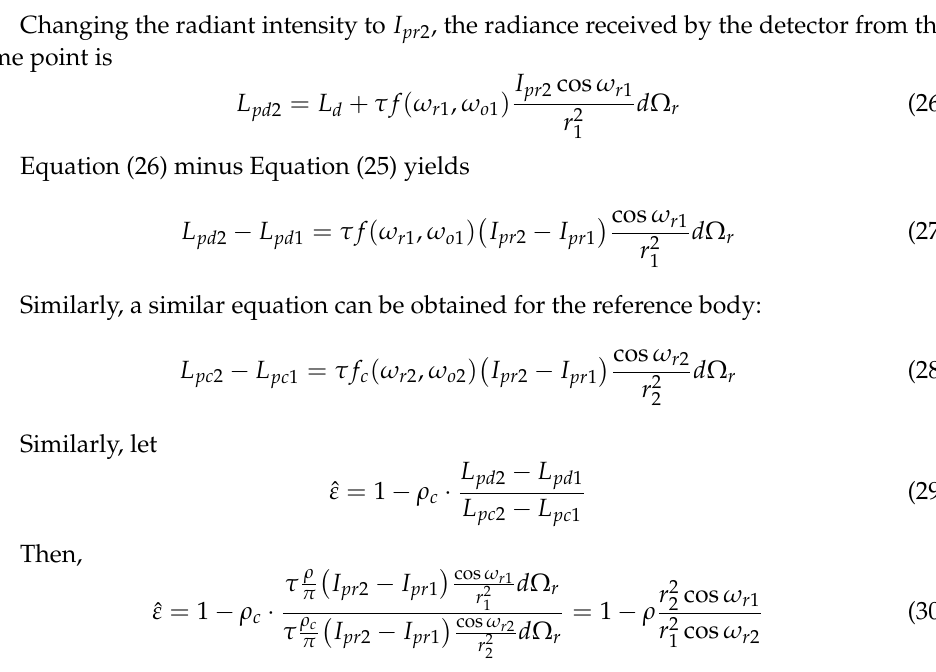
Figure 7. Schematic diagram of a measurement scene irradiated by a point source. Changing the radiant intensity to I pr 2 , the radiance received by the detector from the same point is